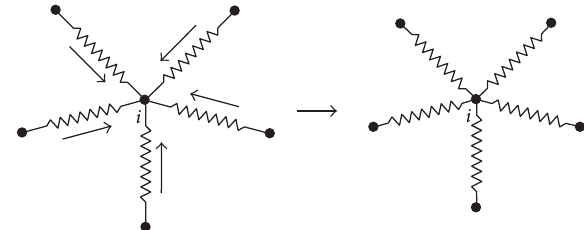
Figure 6: Edge collapsing in 2D.